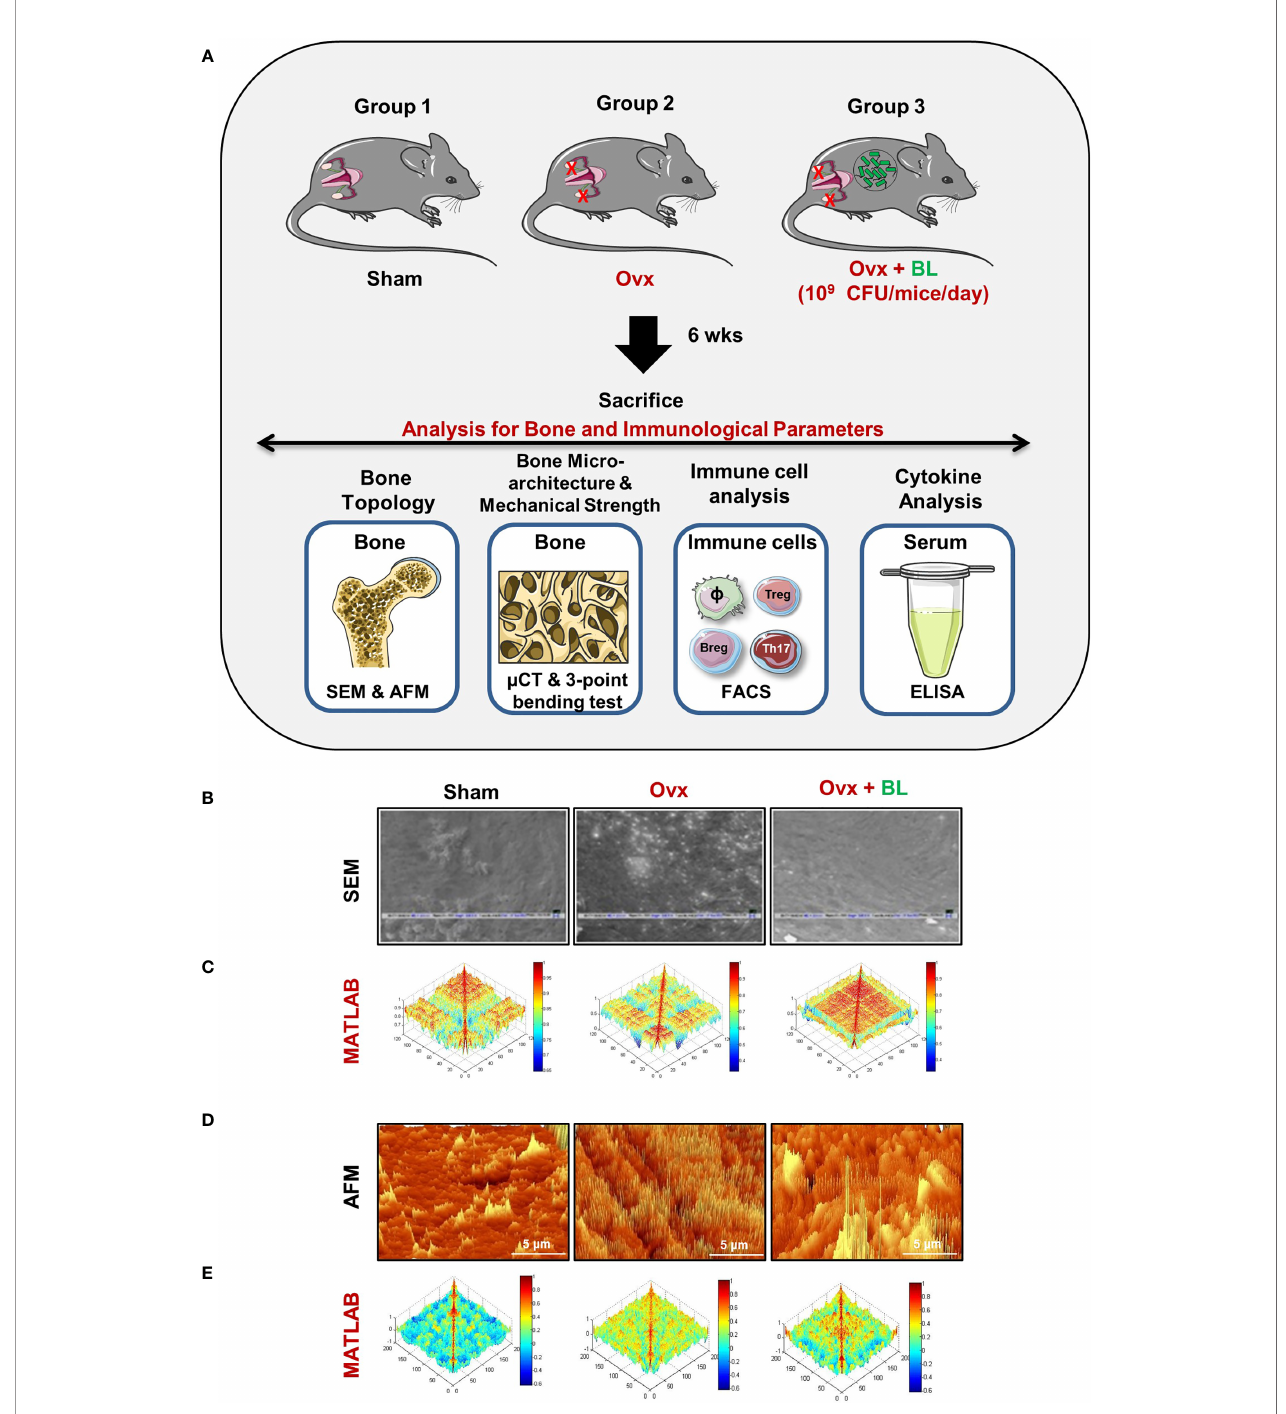
FIGURE 5 | BL administration attenuates bone loss in Ovx mice: (A) Experimental layout followed for in vivo studies. Mice were divided into 3 groups, viz., sham, Ovx, and Ovx + BL groups, that received BL at 10 9 CFU/day orally reconstituted in drinking water. At the end of 45 days, mice were sacri fi ced and analyzed for various parameters. (B) 2D SEM images. (C) 2D MATLAB analysis of SEM images. (D) 3D AFM images. (E) 3D MATLAB analysis of AFM images. The representative images are indicative of one independent experiment, and comparable results were obtained in two different independent experiments with n =6